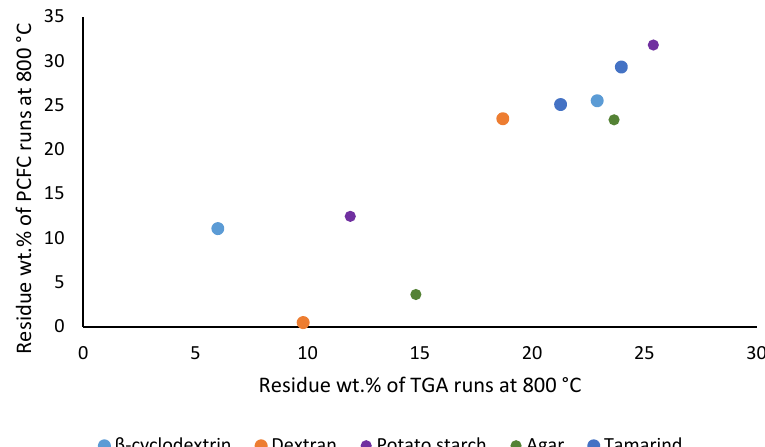
Figure 13. Correlation of char residues (wt. %) from TGA experiments and PCFC runs of the substrates.